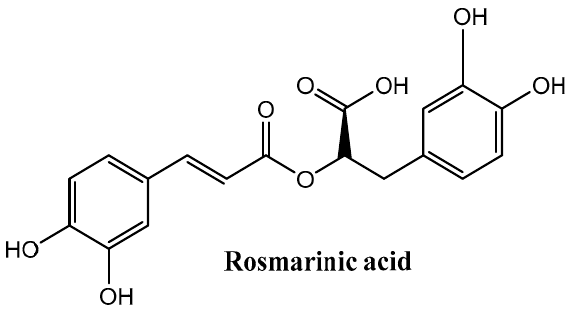
Figure 3. Chemical structure of rosmarinic acid .